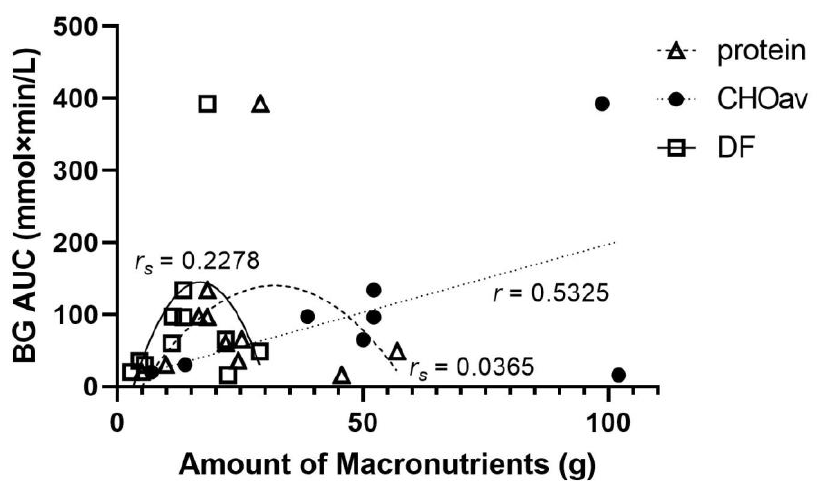
Figure 6. Area under the blood glucose response curve (BG AUC) according the amount of macronutrients or dietary fibre (g) per lentil treatment serving. This plot combines the lentil data of Figures 3 – 5. Quadratic modeling best fit protein ( r s = 0.0365; n = 11; ns ) and dietary fibre (DF) ( r s = 0.2278; n = 11; ns ), and a linear model best fit available carbohydrates (CHOav; r = 0.5325; n = 8; ns ).